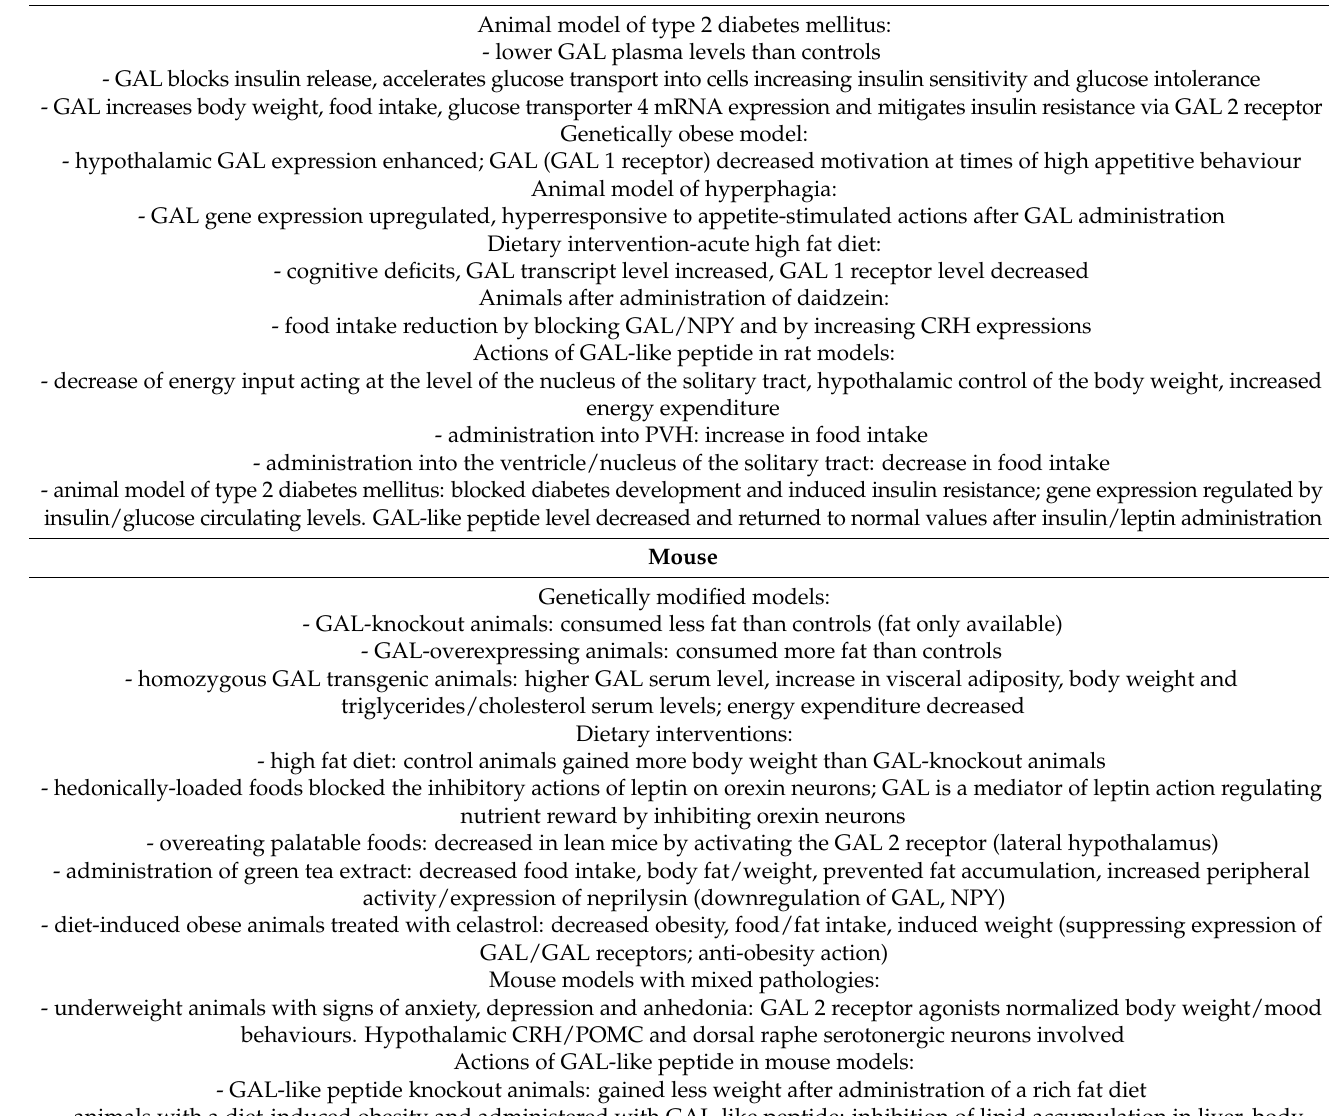
Table 2. Experimental animal models: GAL family of peptides and food intake [2,26,49,50,54,55,57,58,63,66,67,69,70,73–75,77–82]. Rat Animal model of type 2 diabetes mellitus: - lower GAL plasma levels than